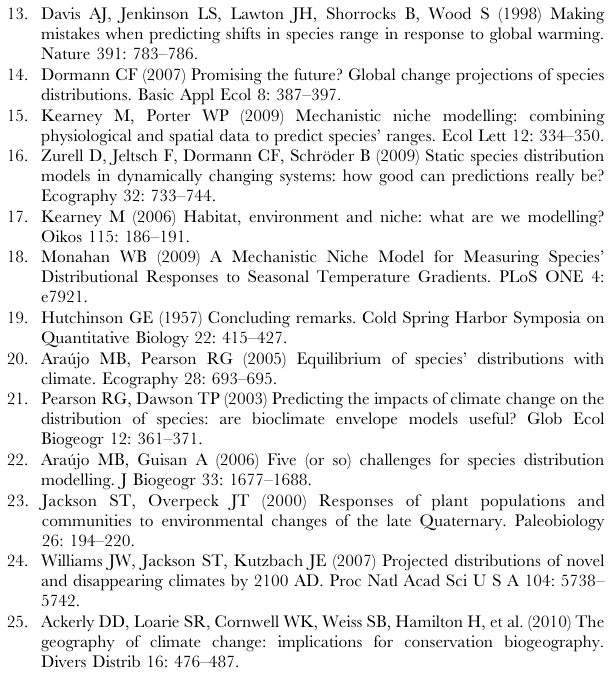
Figure 4. Directional changes in temperature in North America, 1930 – 2004, with respect to the existing LD50 niche. (A) The contemporary environmental space showing grid cells that moved either toward or away from the existing LD50 niche centroid due to directional changes in minimum temperature of the coldest month or maximum temperature of the warmest month (colored grid cells, legend in panel C); grid cells that did not experience directional change are not shown. Labeled regions delineate four environmental spaces with respect to different thermal niche fitness thresholds for the house sparrow (see Fig. 3). (B) Pie charts show the proportions of grid cells moving either toward or away from the existing LD50 niche centroid within each of the four spaces. (C) Geographic projection of grid cells that moved either toward or away from the existing LD50 niche centroid of the house sparrow. Positive ( + ) = moving toward the niche centroid, negative (–) = moving away from the niche centroid.